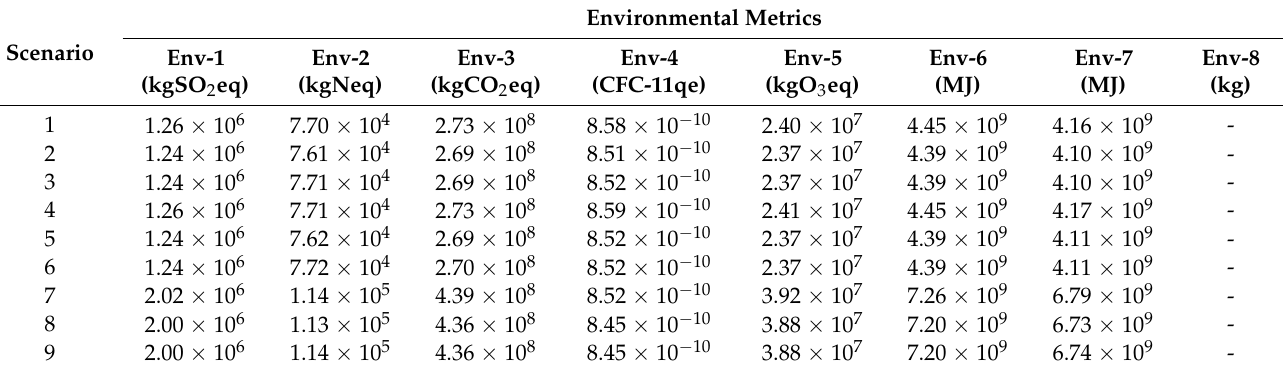
Table 6. Environmental impact analysis results for stages C2 to C4.